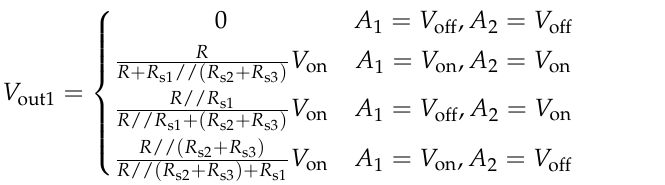
Figure 7. The diagram of multi-valued logic circuit based on rotation mechanism.